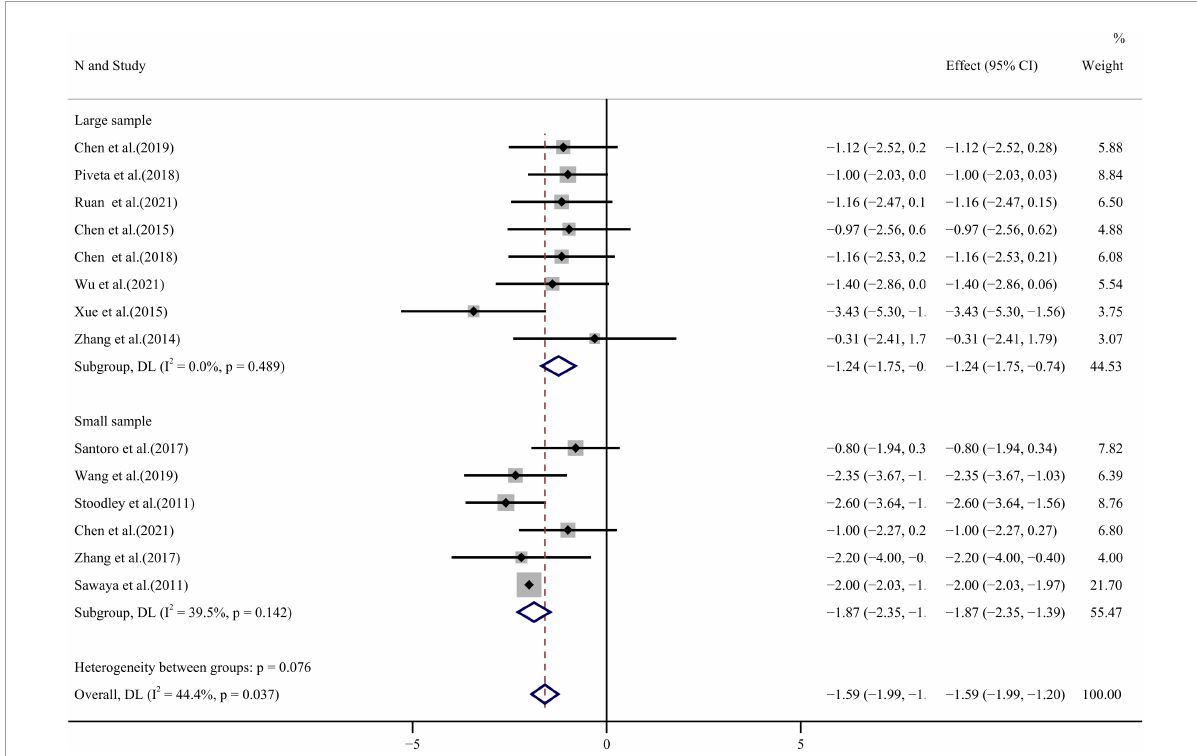
FIGURE3 LVEF forest plot [Forest plot of weighted mean difference (WMD) of the association between LVEF absolute value reduction and anthracyclines